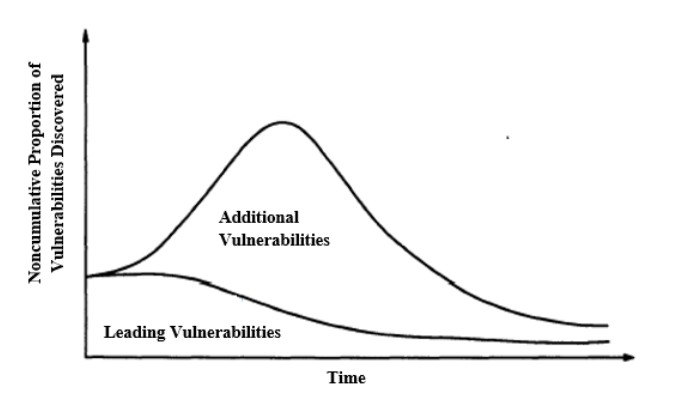
Fig. 2. Categorization of noncumulative vulnerabilities